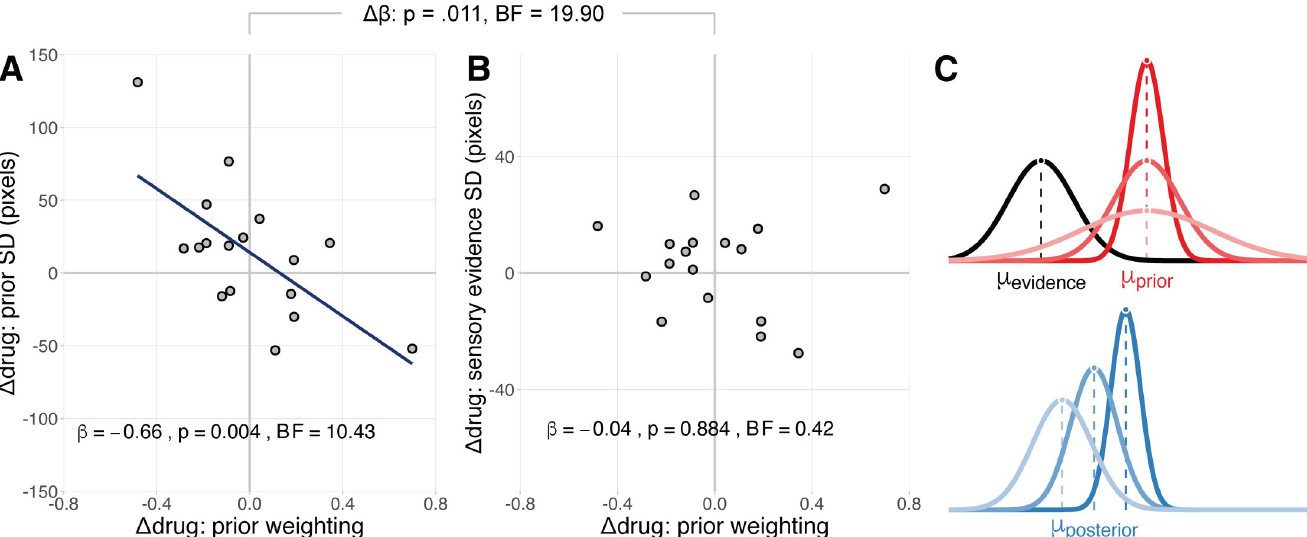
Fig 4. Decomposition of noradrenergic effects on prior weighting. A-B) The relationship between the drug effect on prior weighting and Bayesian model estimates of the drug effect on the standard deviation of the prior distribution (A) and the standard deviation of the sensory evidence distribution (B). C) Schematic illustration of how the effect of atomoxetine on prior precision (red) determines the extent to which (posterior) estimates of performance (blue) are drawn towards the prior, for a given sensory evidence (black). Lighter shades of red represent less precise priors. The effect of prior precision on the posterior is illustrated with corresponding shades of